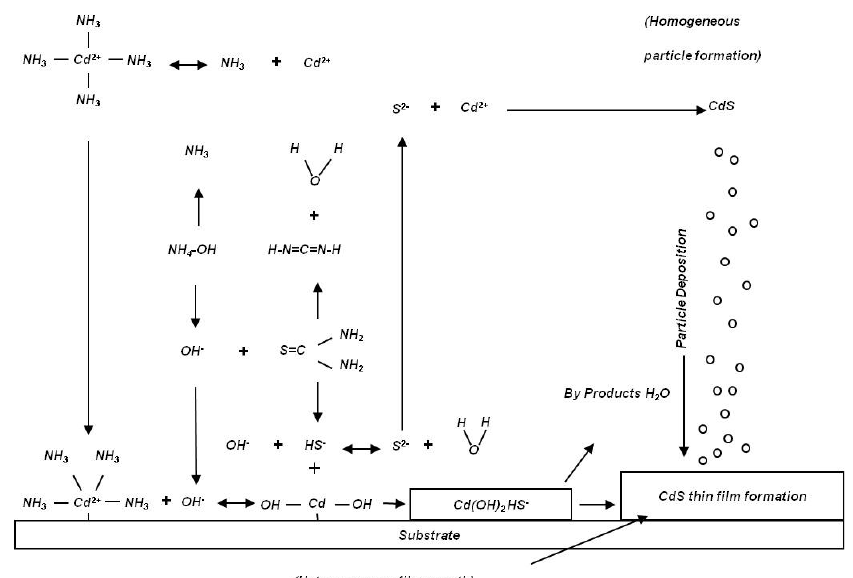
Figure 10. Growth mechanism of CdS thin film in the batch CBD